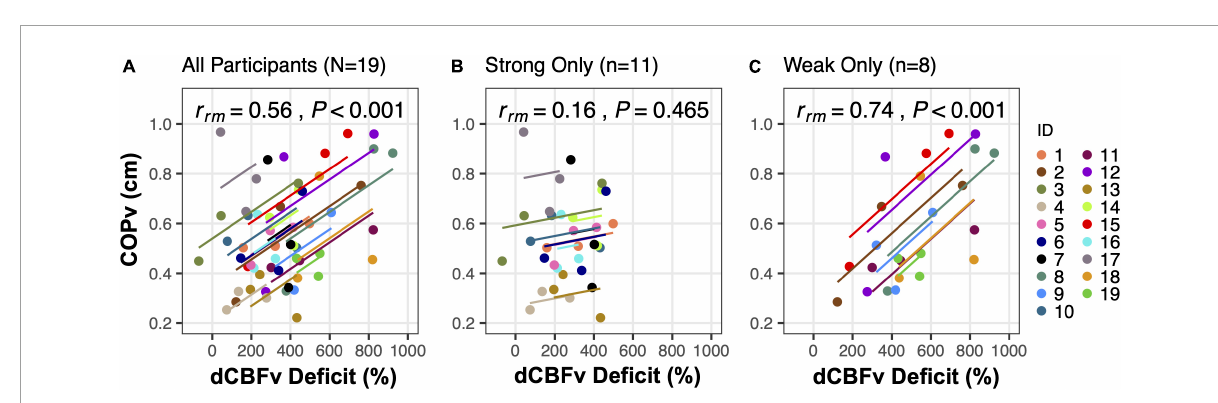
FIGURE8 Postural sway response to cerebral hypoperfusion. Repeated measures within-participant correlations between diastolic cerebral blood flow velocity deficit (dCBFv, quantified as the difference between dCBFv in the middle cerebral artery following the supine-stand transition and its baseline value in the supine posture before any intervention) and mean center of pressure vector (COPv) are shown. Analyses were performed among (A) all participants, and groups of (B) strong regulators only, or (C) weak regulators only, as identified through an a posteriori cluster analysis (112). The number of participants ( n ) included in each condition are shown at the top of each respective plot. Parallel slopes are fitted for each participant with ANCOVA using data from the 3 postural transitions, such that the overall model error is minimized. The repeated measures correlation coefficient ( r rm ) is derived from a ratio of the sum of squares. Adapted from Fitzgibbon-Collins et al. (112).